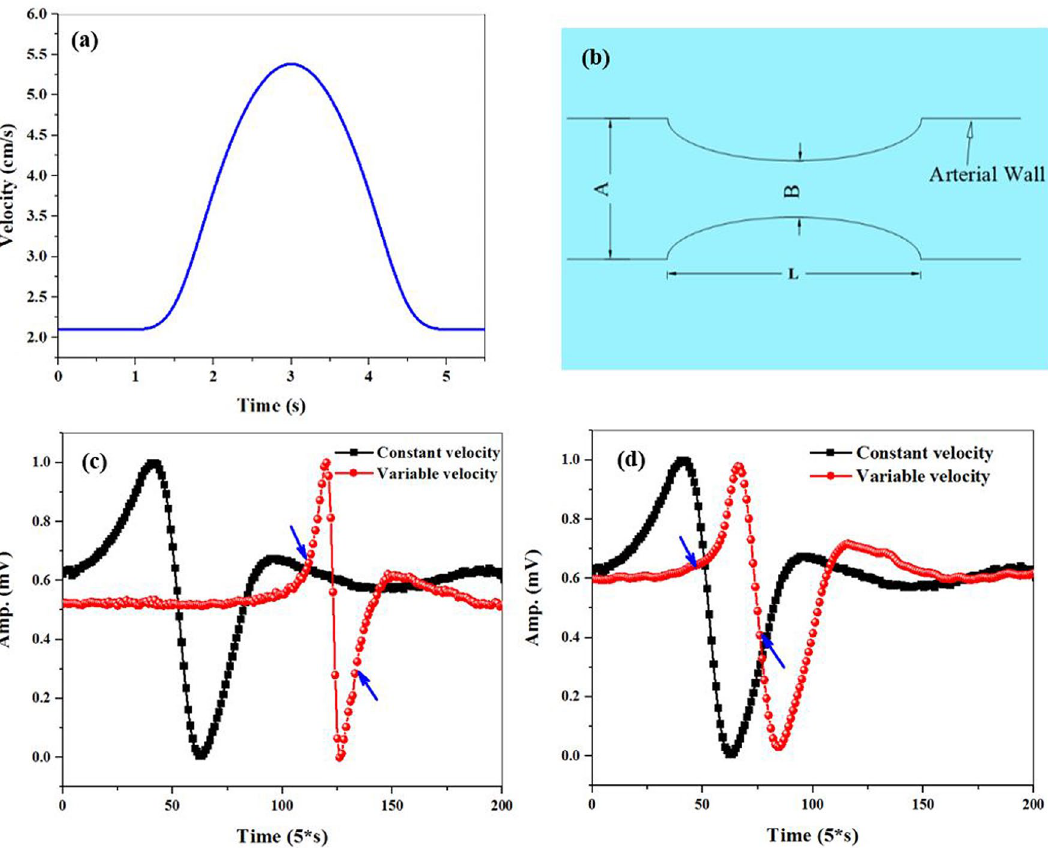
Figure 5. ( a ) A simple model scheme of a stenosis artery (A: diameter of the artery, B: diameter of the artery in the stenosis region, and L: length of the stenosis), and ( b ) sinusoidal variable velocity profile. The spike-like signals of the microwire for instantaneous velocity applied to the microwire when its location is ( c ) near the first edge of the vapor cell, and ( d ) near the middle of the vapor cell (time interval of applying instantaneous velocity marked with blue